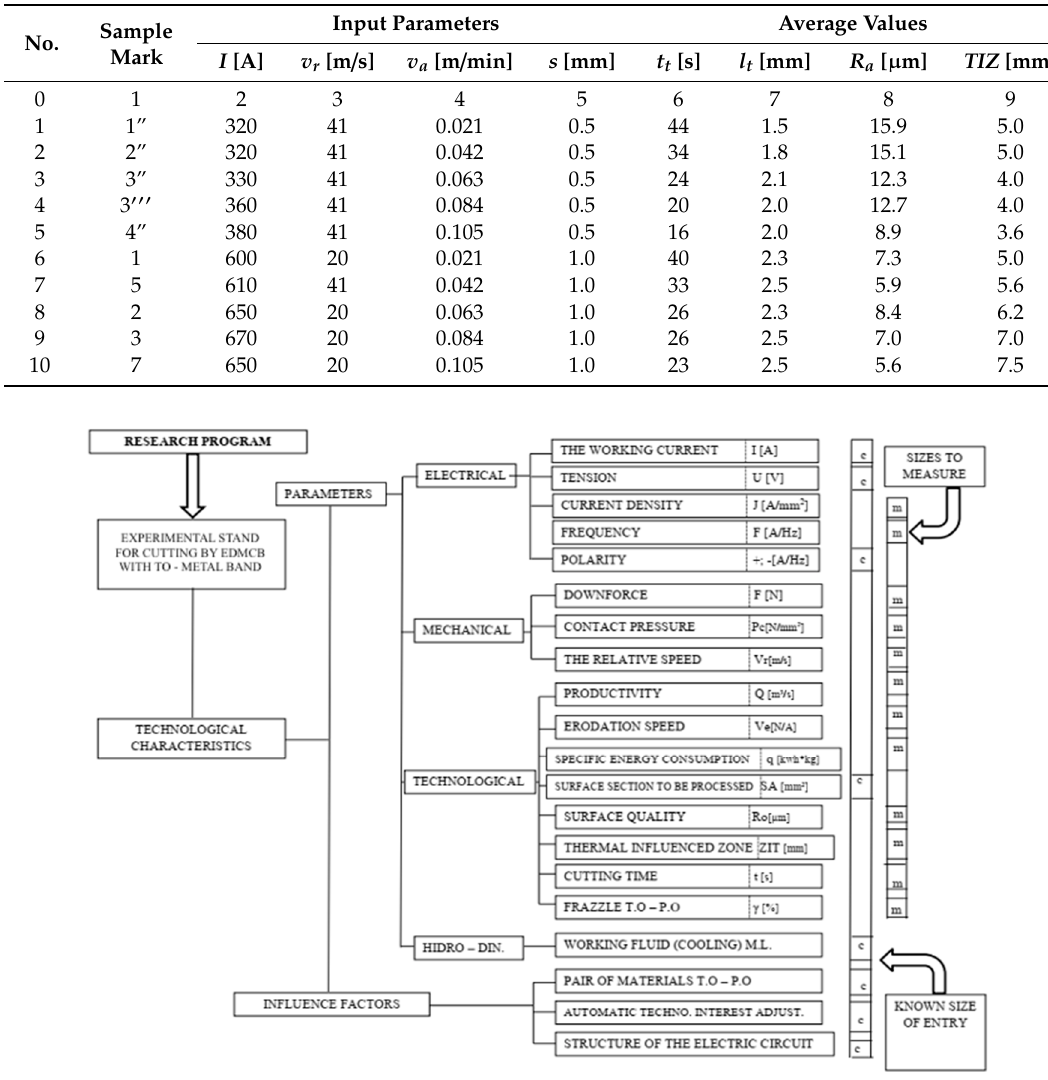
Figure 1. The experimental research programming through processing by electrical discharge machining with contact breaking (EDMCB) with Transfer Object (TO)—metal band.